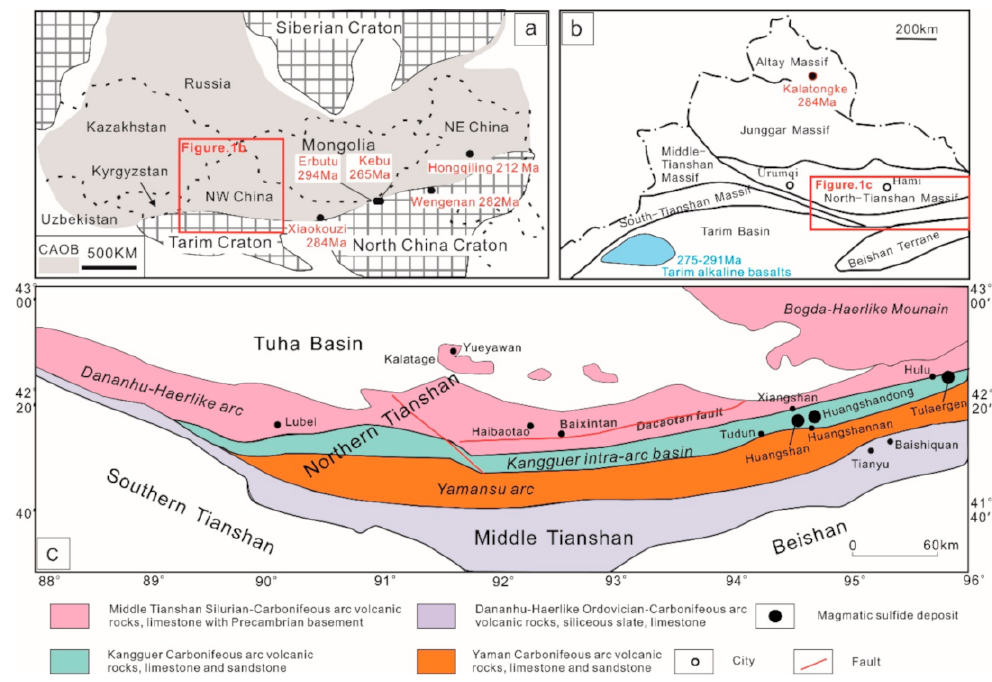
Figure 1. ( a ) Location map of the study area and Ni-bearing mafic-ultramafic intrusions in the south margin of the Central Asian Orogenic Belt (CAOB) (modified after Jahn et al. [34]); ( b ) schematic division of massifs and the location of the Northern Tianshan, NW China (modified after Ruan et al. [36]); and ( c ) a regional geological map showing the distribution of early Permian mafic-ultramafic complexes in Northern Tianshan (modified after Deng et al.